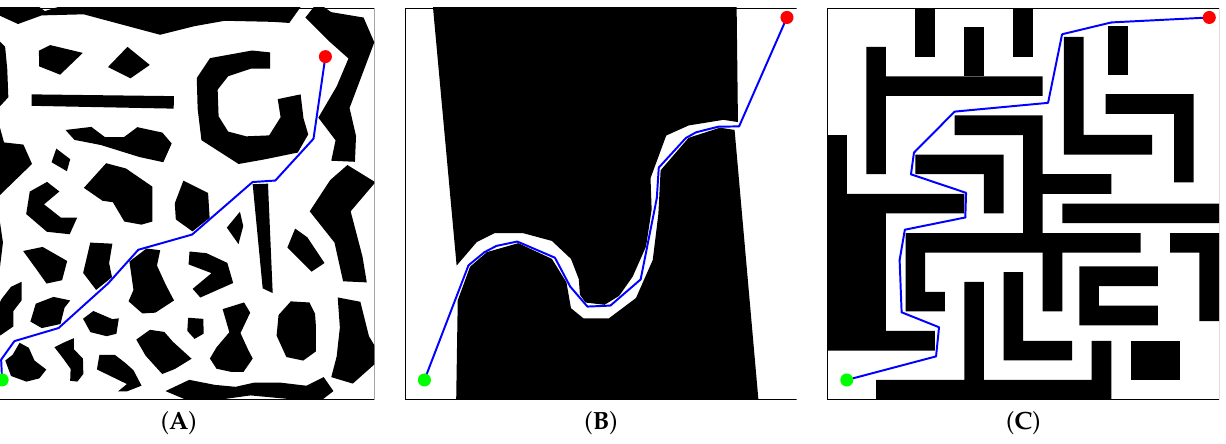
Figure 5. Best paths achieved by VLV-DE for test cases ( A – C ), respectively.